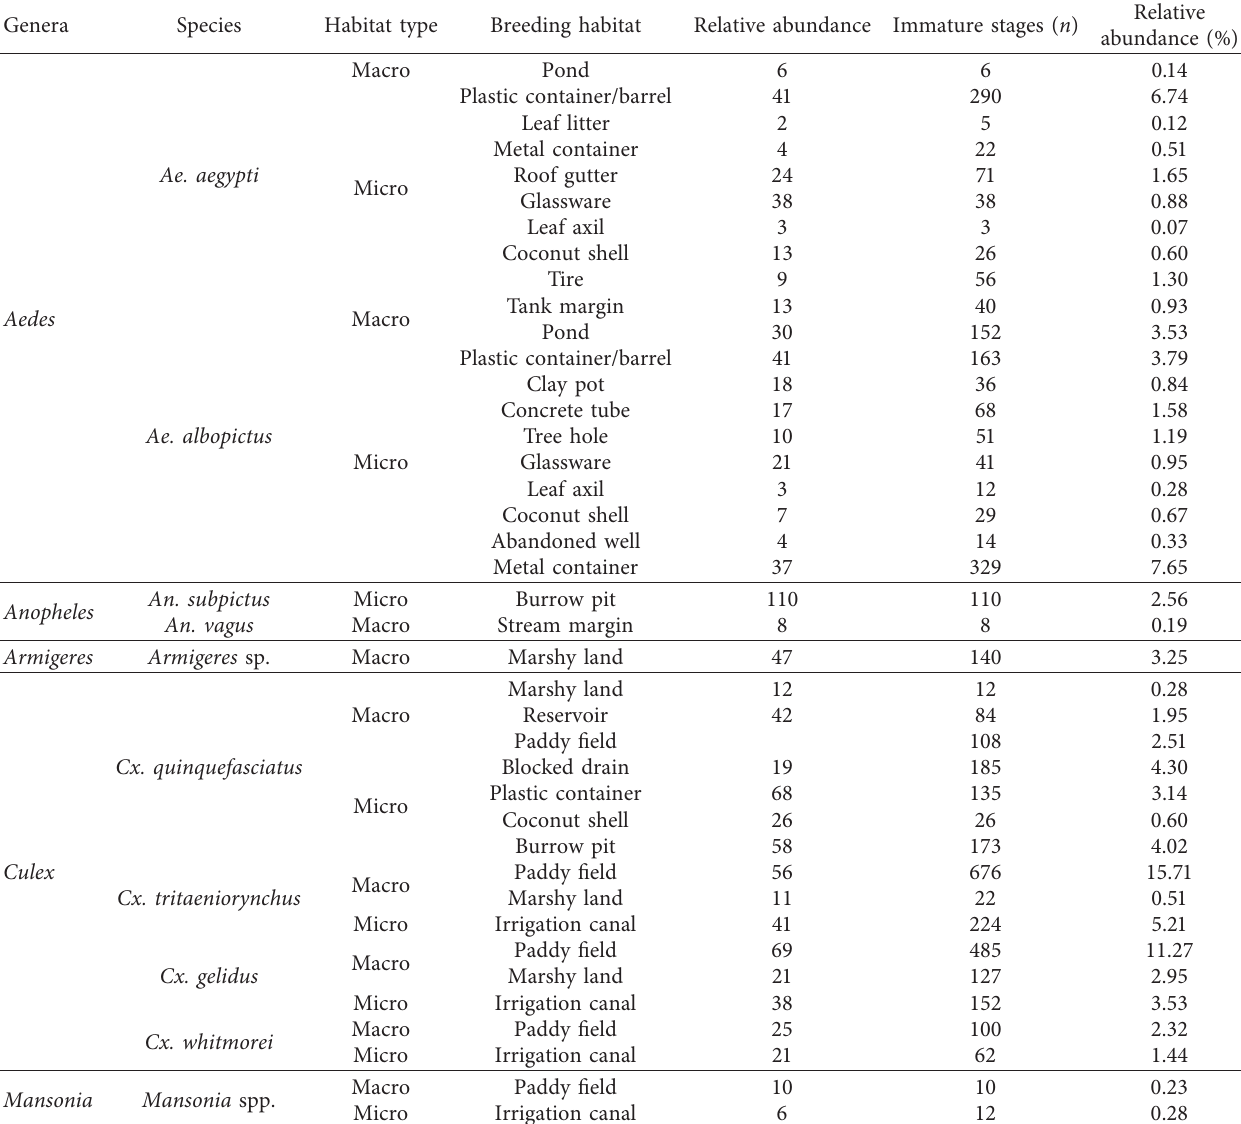
Table 4: The abundance of the immature stages of medically important mosquito species encountered in each breeding habitat. Genera